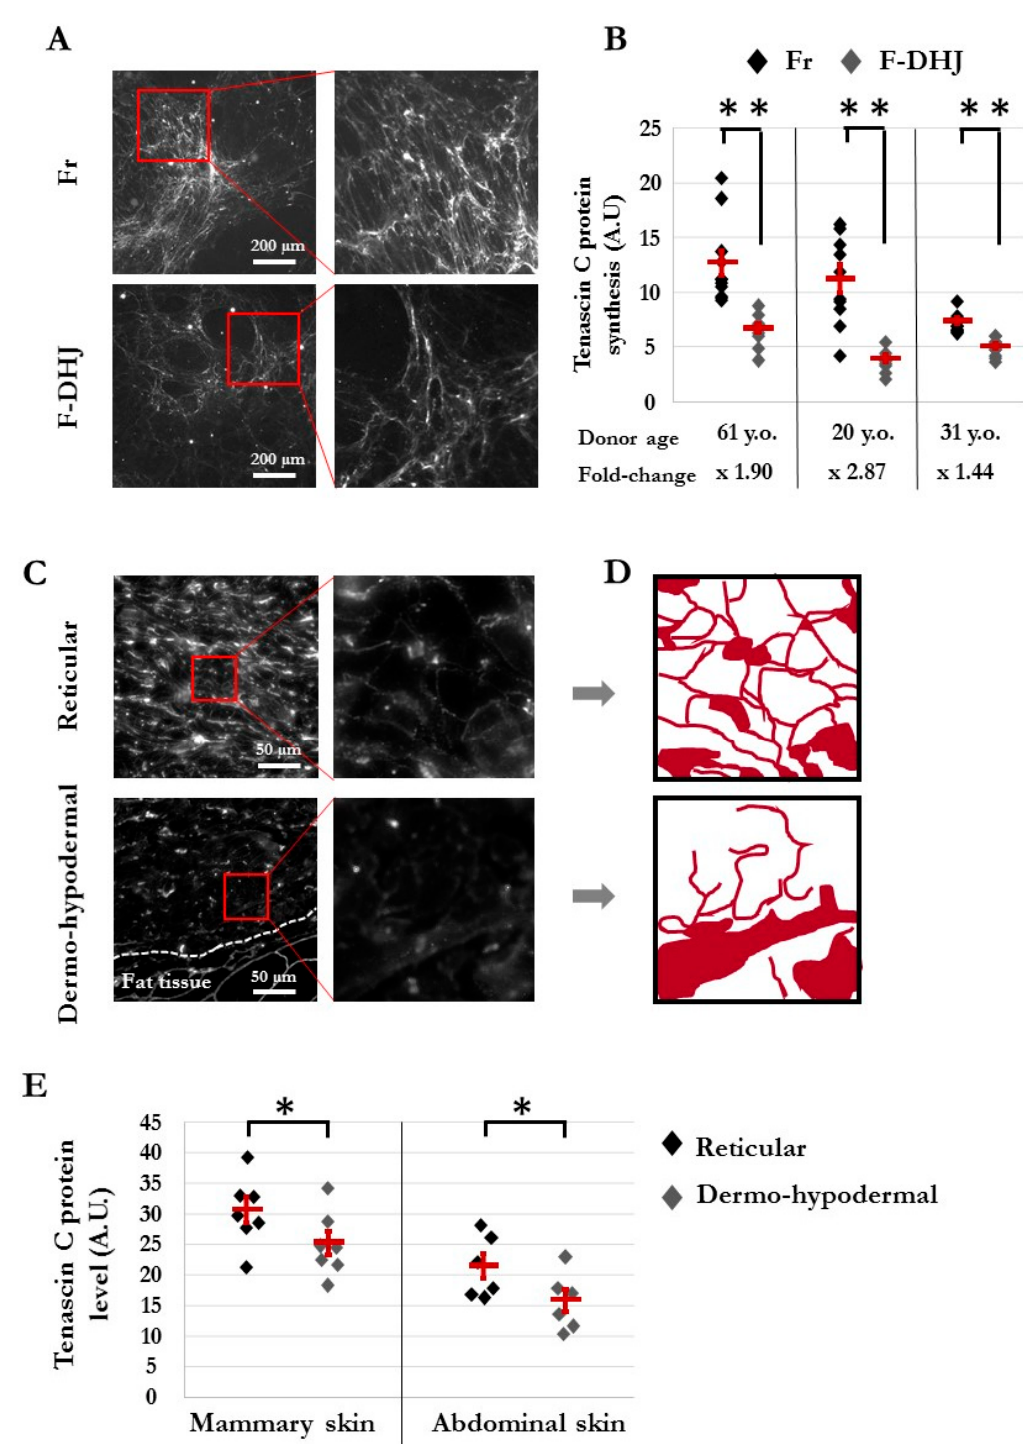
Figure 6. Architecture of the tenascin C (TNC) meshwork produced in vitro by Fr and F-DHJ fibroblasts in skin sections. ( A ) Immunostaining pictures of the TNC meshwork produced by Fr and F-DHJ cells in 2D cultures. ( B ) Quantification of TNC secreted in 2D cultures. Cell samples from 3 donors were used. Values corresponding to 10 replicate analyses for each cell sample are shown. Means ± SEM are indicated (** p < 0.01, Wilcoxon test) A.U. for arbitrary units. ( C ) Photographs of TNC immunostaining in skin sections, illustrating the structural differences between reticular dermis and the dermo-hypodermal junction area (representative from 13 analyzed donors). ( D ) Image reconstitution of TNC meshwork architectures based on the immunostaining photographs shown in panel ( C ). ( E ) Quantification of TNC in the skin reticular and dermo-hypodermal areas. Values